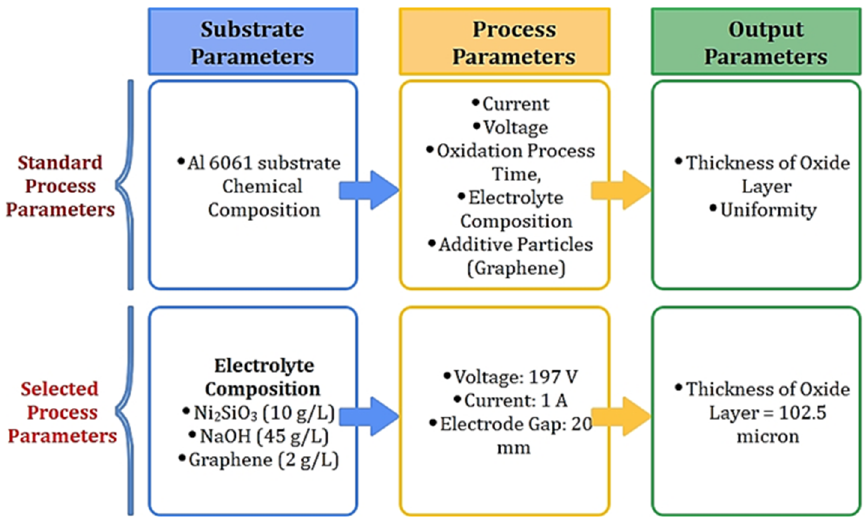
Figure 2. Output parameters after experimentation.